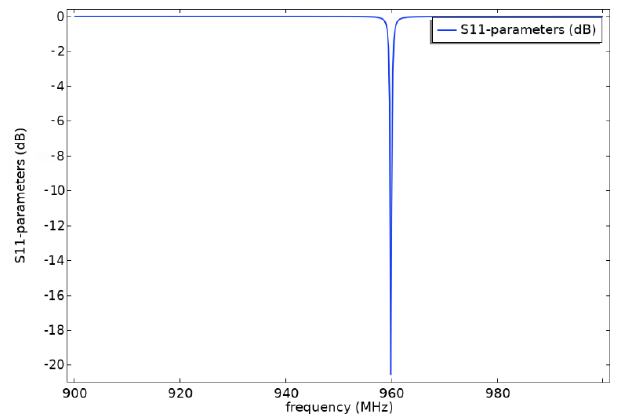
Figure 8. S-parameter analysis curve.